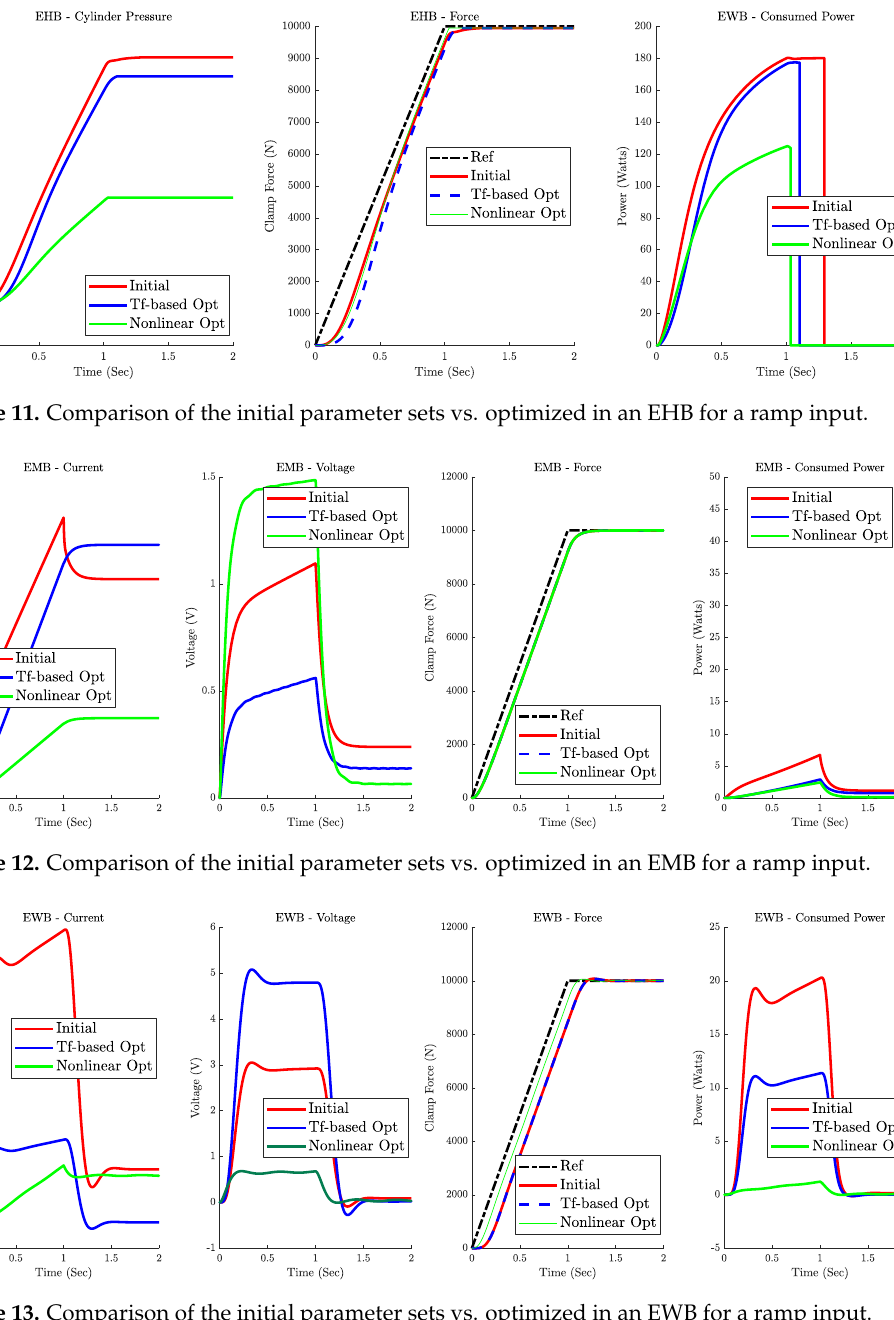
Figure 13. Comparison of the initial parameter sets vs. optimized in an EWB for a ramp